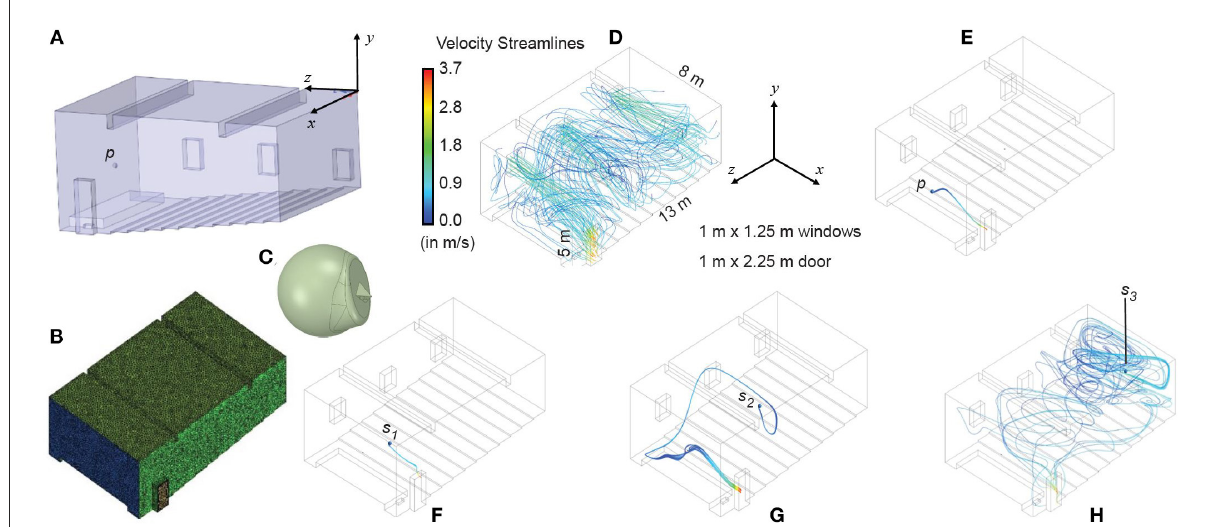
FIGURE7 In a well-ventilated room, infection risk is strongly dependent on the location of the infected individual. (A) Digitized geometry of a classroom (based on direct measurements of an auditorium-style classroom in a tropical setting). The position of the instructor’s head is marked by p . (B) Meshed space interior to the bounds of the classroom. (C) Typical head geometry for the emitter subtracted from the classroom mesh, with realistic nostril diameters. (D) Mixing of velocity streamlines in the classroom with the windows as the inlet and the door as the outlet. The panel includes the layout and plan dimensions of the ventilated classroom. (E–H) Flowlines of exhaled virions showing the impact of emitter location (blue dot: p represents the instructor’s head location, s 1 − 3 represent the students’ head locations) on local concentrations of virions. Note that s 1 is in the front seat , s 2 is in the middle of the classroom, and s 3 is in the rear seat. Local concentrations are dependent on fluid dynamics within the classroom, suggesting that even if the average concentration of virions in a room is below the infectious threshold, individuals may become infected over time based on their location downstream of the emitter.